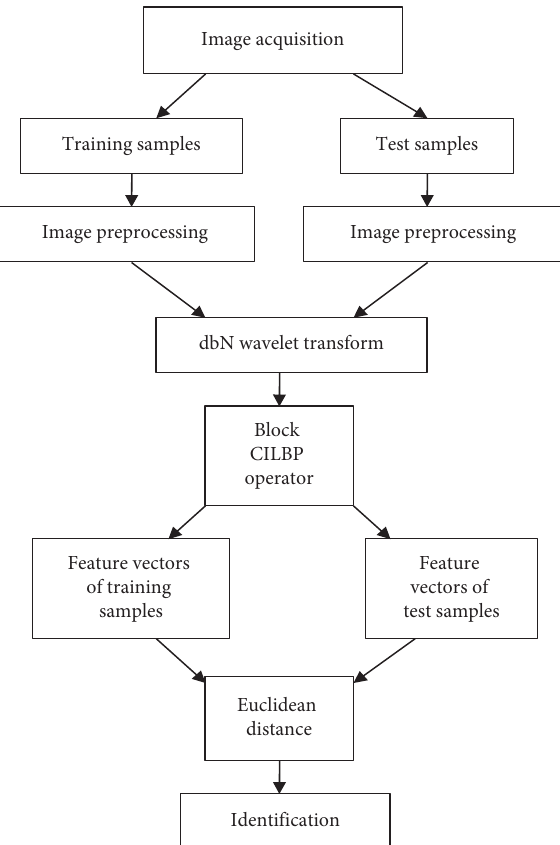
Figure 3: Flowchart of CILBP and dbN